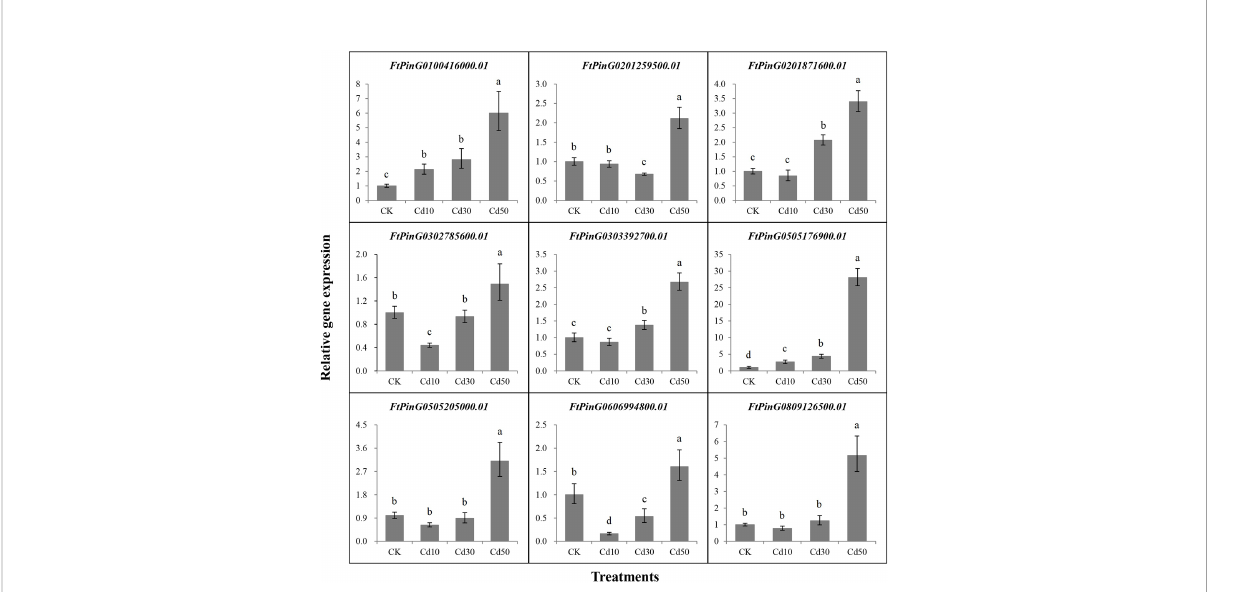
FIGURE 11 The relative gene expression for 9 core genes was highly induced by Cd stress of 50 mg/L. CK, Cd10, Cd30, and Cd50 indicates the Cd concentration 0 mg/L, 10 mg/L, 30 mg/L, and 50 mg/L, respectively. Different lowercase letters on the top of bars indicate signi fi cant differences between treatments according to Duncan t -test ( p -value <